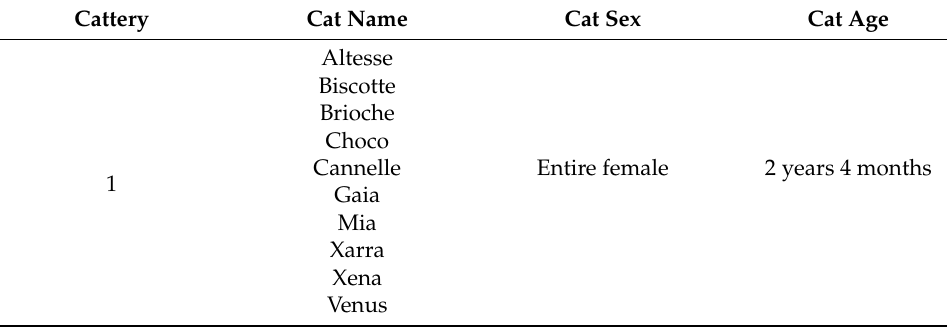
Figure 1. General layout of the litter trays in the catteries for the study. The litter trays are depicted as grey rectangles. Cattery 1: entire female cats, cattery 2: entire male cats, cattery 3: senior cats, cattery 4: overweight cats. Litter trays are placed as far as possible from each other and following space constraints. Table 1. Distribution of cats in catteries, cats’ sexes and